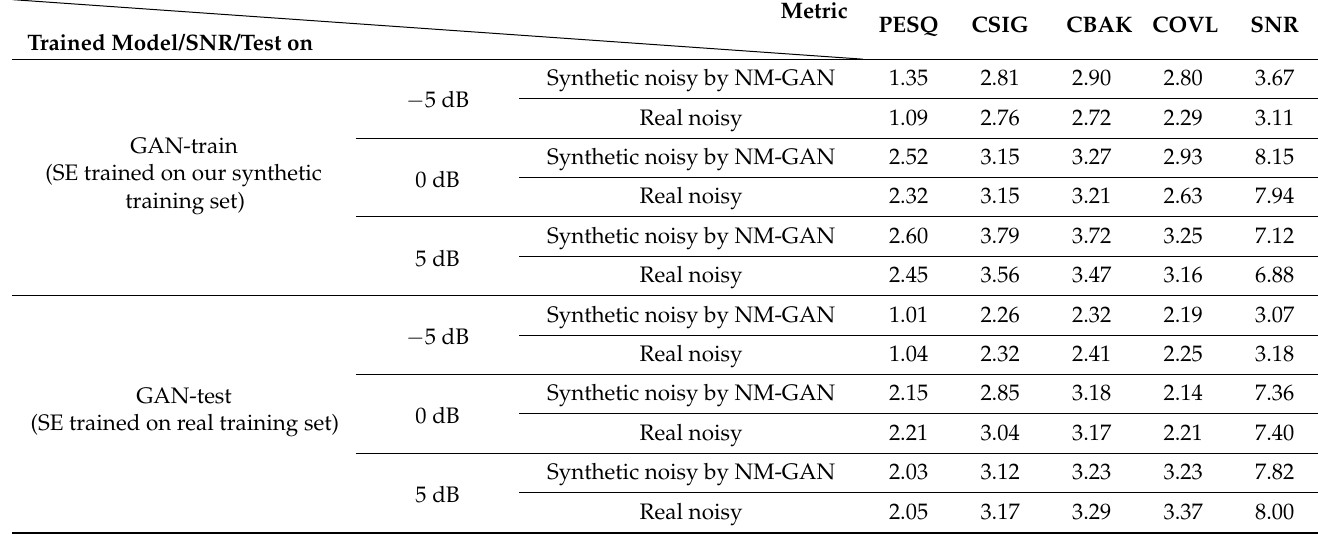
Table 1. Evaluation results for the first group of “GAN-train” and “GAN-test”